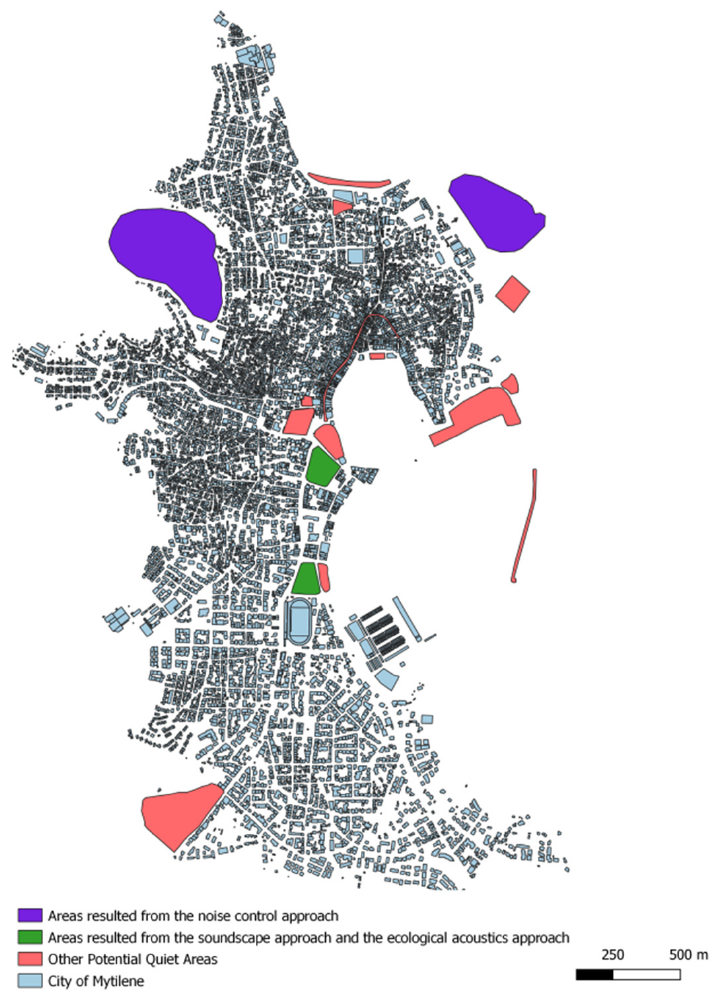
Figure 4. The resulted potential quiet areas.